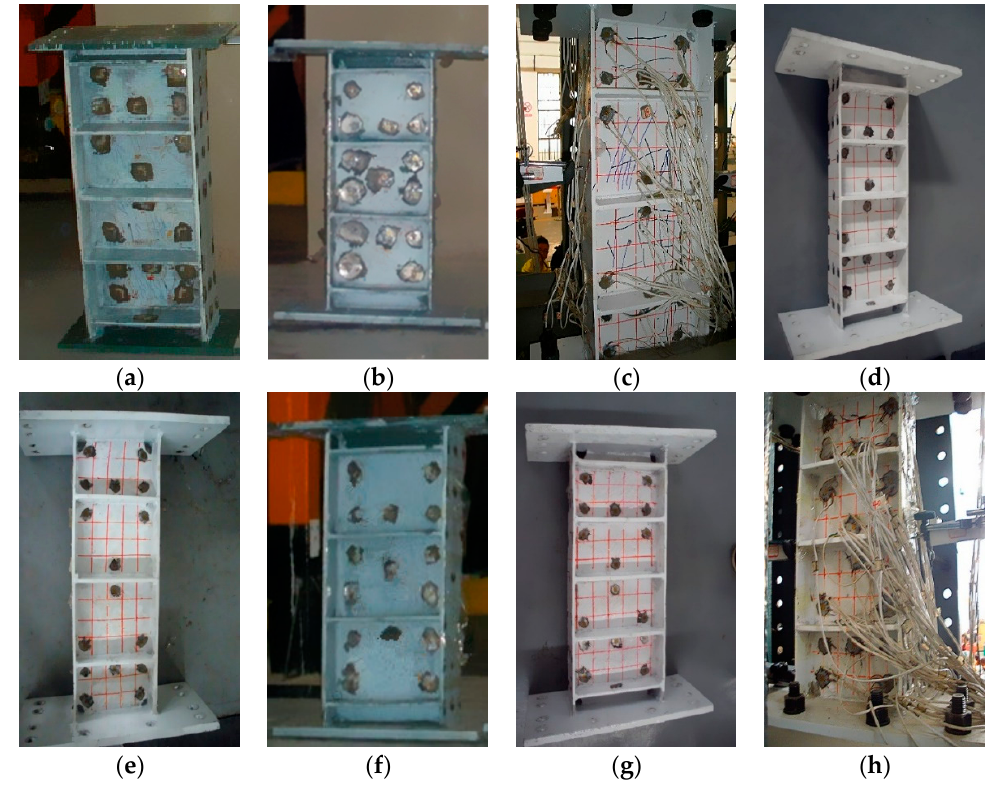
Figure 1. Experimental specimens. ( a ) L1; ( b ) L2; ( c ) L3; ( d ) L4; ( e ) L5; ( f ) L6; ( g ) L7; ( h ) L8. Table 1. Parameter design of each test specimen.